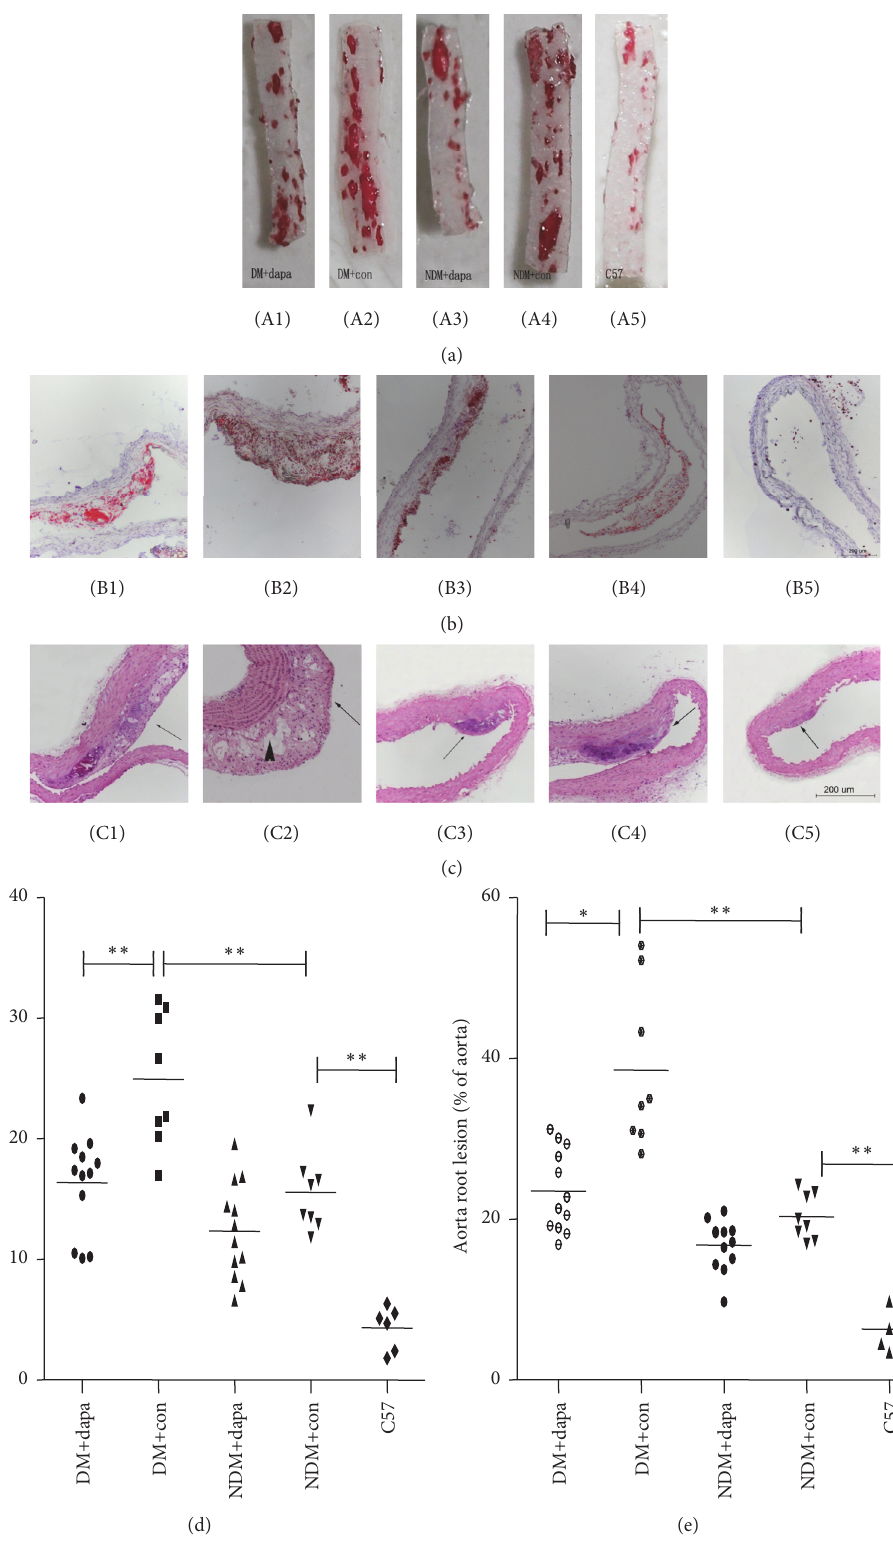
Figure 3: Dapagliflozin attenuated the formation of atherosclerotic lesion in ApoE −/− mice. (a) Oil red O staining of thoracic aorta and abdominal aorta. Numbers 1–5 indicated diabetic treatment group, diabetic control group, nondiabetic treatment group, nondiabetic control group, and C57BL/6J control group, respectively; (b) oil red O staining of aortic roots (100x); (c) HE staining of aortic roots (100x), the small black arrow showed lesions and the big black arrow showed the necrotic lipid core of lesions; (d) percentage of arterial lesions in aorta; (e) percentage of lesions at aortic root in lumen cross-sectional area; ∗ 𝑝 < 0.05 ; ∗∗ 𝑝 < 0.01